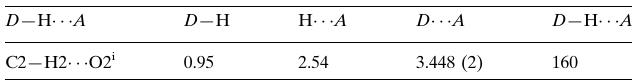
Hydrogen-bond geometry (A˚ , (cid:1)